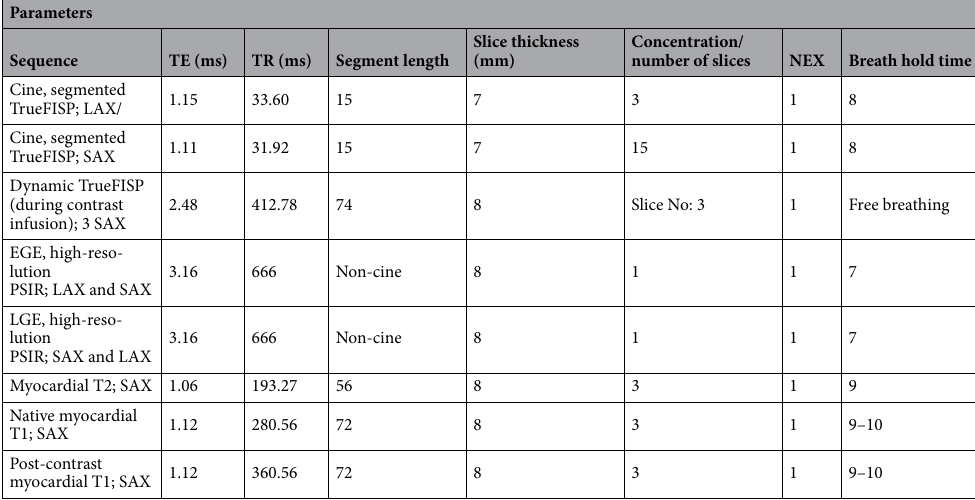
Table 1. Details of CMR sequences and typical parameters. NEX Number of excitations, TE Echo time, TR Repetition